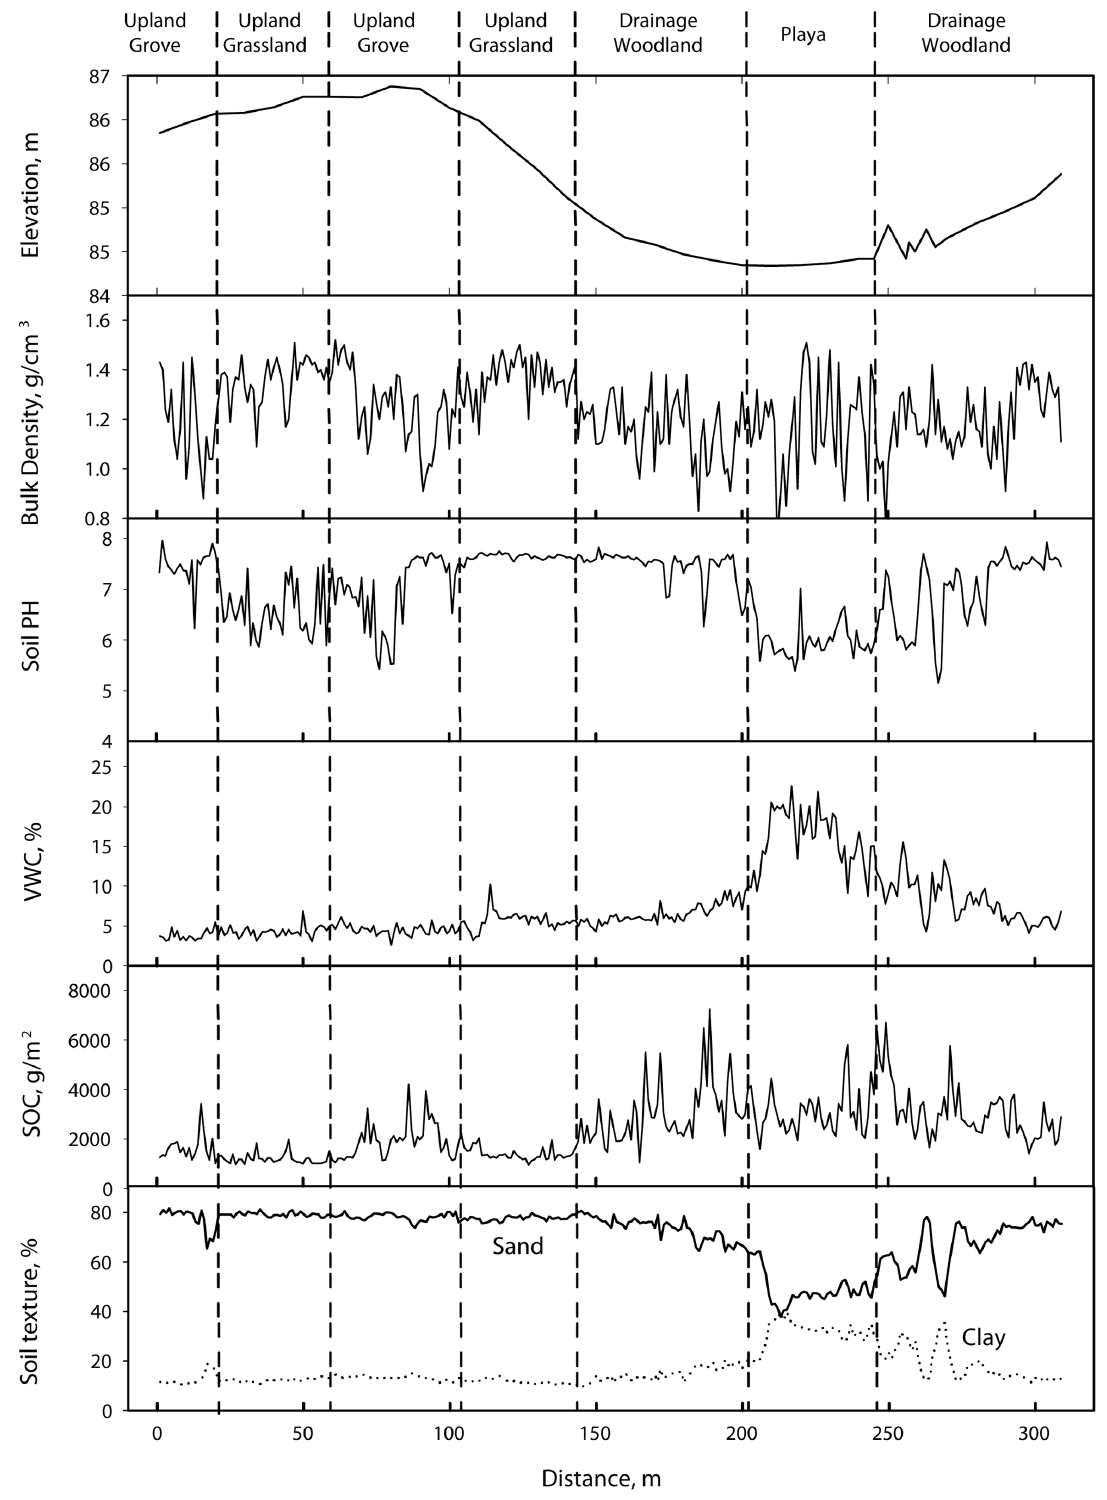
Figure 2. Topoedaphic variations based on sampling at 1-m intervals along a transect extending from plant communities in a savanna parkland upland (grassland, shrub cluster, grove), through intermittent drainage woodlands and into a playa savanna community. VWC = soil volumetric water content; SOC = soil organic carbon. doi: 10.1371/journal.pone.0084364.g002 PLOS ONE |